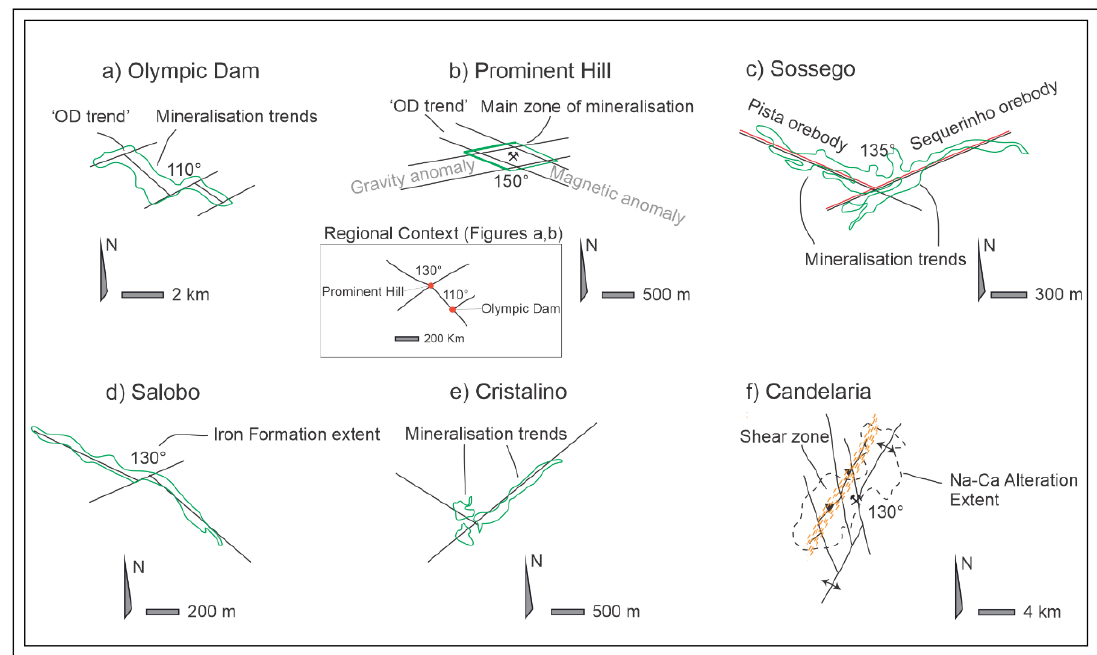
Figure 6. Geometries and mineralisation trends of IOCG mineralisation at Olympic Dam, Prominent Hill, Sossego (Pista and Sequerinho orebodies), Salobo, Cristalino and Candelaria. These examples highlight the relationships of mineralisation with the conjugate extension of two or more major structures or fabrics, at obtuse angles to one another, resulting in a “stepped” pattern of mineralised zones, space creation, dilational breccias and the formation of brecciated, permeable pipe-conduits at their intersections.